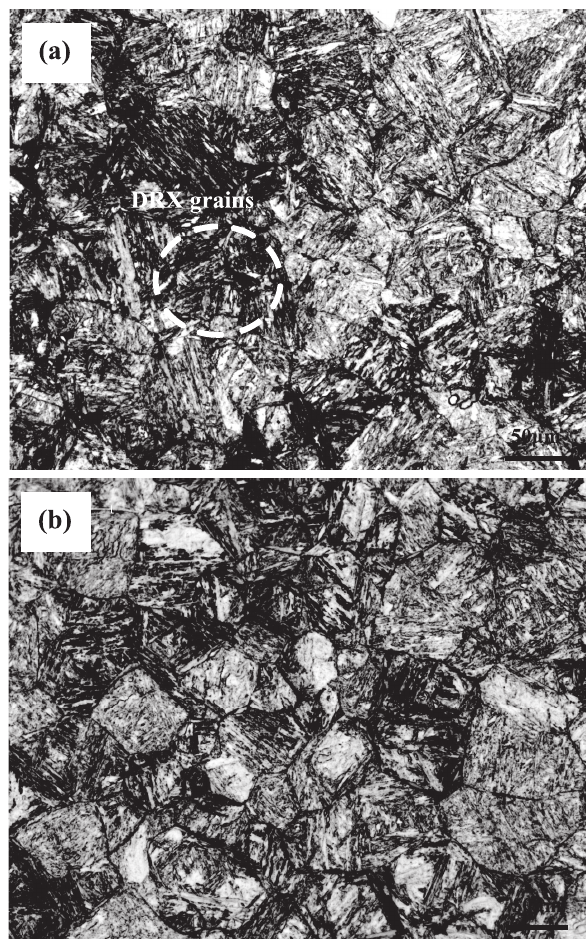
Fig. 3: Microstructure of specimens deformed with strain rate of 0.1 s − 1 at temperatures of (a) 1000 °C and (b) 1150 °C.